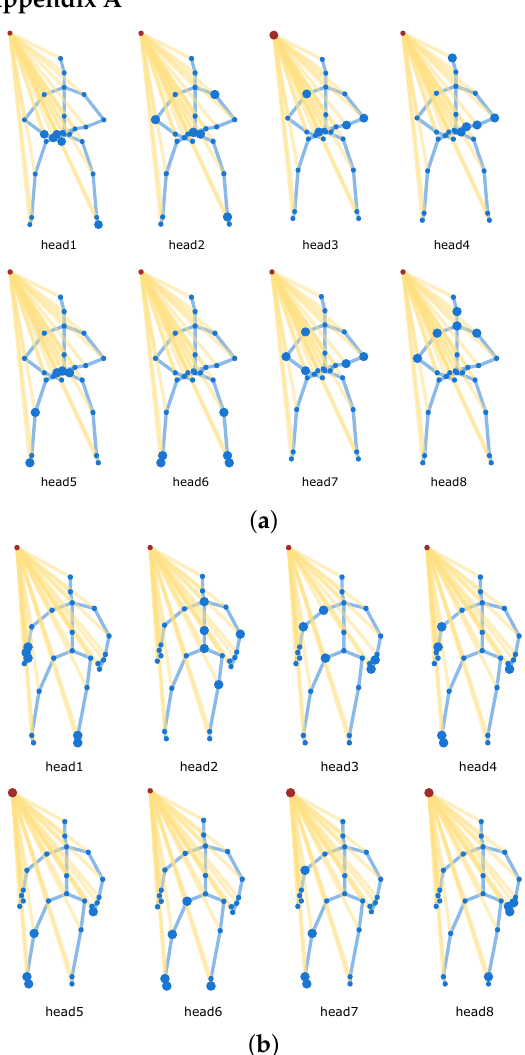
Figure A1. Visualization of the attention responses of the last SRU block in ST-RT model with respect to two actions, i.e., clapping ( a ) and kicking something ( b